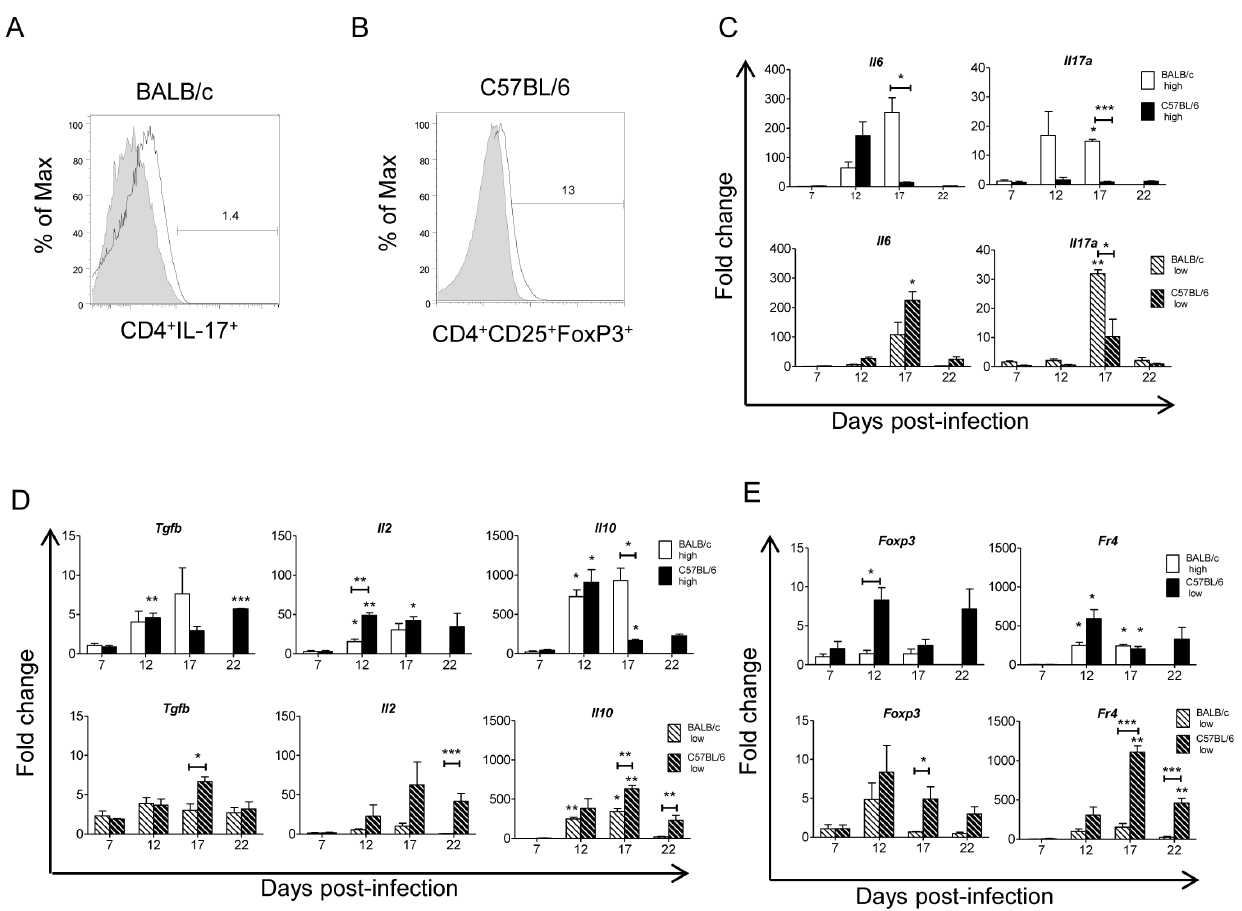
Figure 4. Th17 and T reg cells were isolated from the hearts of BALB/c and C57BL/6 mice, respectively. BALB/c mice were infected with high inoculum (open bar) or low inoculum (open dashed bar). C57BL/6 mice were infected with high inoculum (filled bar) or low inoculum (filled dashed bar). ( A ) Percent of CD4 + IL-17 + cells isolated from the hearts of BALB/c mice infected with high inoculum at 17 d.p.i. ( B ) Percent of CD4 + CD25 + FoxP3 + cells isolated from the hearts of C57BL/6 mice infected with low inoculum at 17 d.p.i. ( C ) Quantitative RT-PCR from total mouse heart tissue RNA from non-infected (NI) mice and mice infected with either high inoculum (top) or low inoculum (bottom) at 7, 12, 17 and 22 d.p.i., utilizing Il6 and Il17a probes. ( D ) as for (C) but utilizing Tgfb, Il10 and Il2 probes. ( E ) as for (C) but utilizing Foxp3 and Fr4 probes. For ‘‘A’’ and ‘‘B’’ the data represent the results from two experiments performed with 25 and 35 mice per group, respectively. For ‘‘C’’, ‘‘D’’ and ‘‘E’’ the data were normalized with respect to NI mice (Fold change: 1) and represent the results from at least two independent experiments performed with 3 mice per experimental group. Statistically significant differences between infected and non-infected mice (0 d.p.i.) and between BALB/c and C57BL/6 mice under each treatment are shown: * p , 0.05,** p , 0.01 and *** p ,